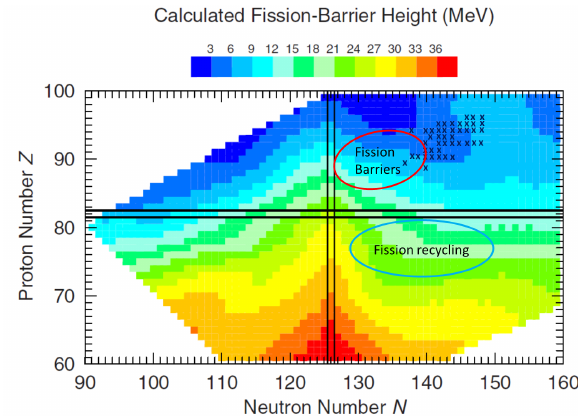
Figure 11. Z-N contour map of predicted fission barrier heights predicted by the macroscopic microscopic liquid drop model by Möller et al. [26]. The crosses indicate the area where fis- sion barriers have been measured using light charged particle beams and actinide targets. The red oval indicates the area where radioactive beams of su  cient intensity to perform inverse- kinematics fission barrier measurements are expected from the FRIB facility. Unfortunately, predicted intensities are too weak to explore the region proposed for fission recycling (magenta oval). The figure is taken from Ref. [26] and slightly